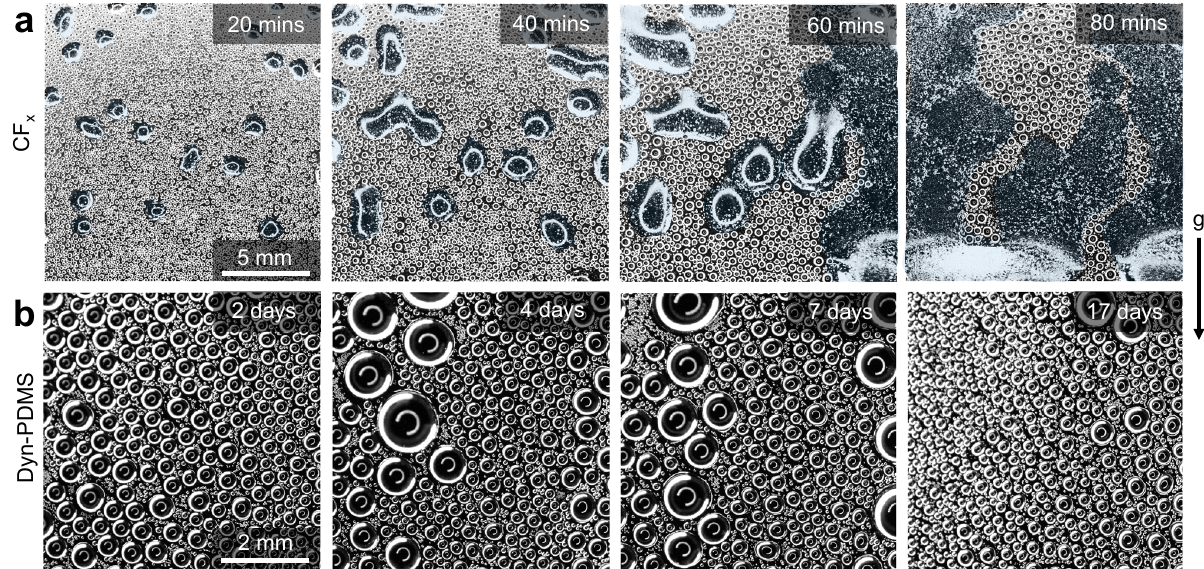
Fig. 3 Coating durability during steam condensation. Time-lapse optical images of steam condensation on a ( a ) CF x coated Si wafer and ( b ) 10 nm dyn- PDMS (1.5:1) coated Si wafer. Water blisters grew beneath the CF x fi lm and resulted in coating delamination. The water blisters in a are false-colored with light blue to aid in visualization. The stable dropwise condensation lasted more than 17 days on the dyn-PDMS fi lm, which did not fail during the entire experimental run.